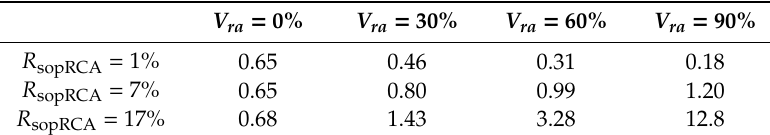
Figure 12. D RAC ( × 10 − 11 m 2 / s) varying with water absorption and volume fractions of RCA. Table 3. The D RAC ( × 10 − 11 m 2 / s) corresponding to Figure 12.